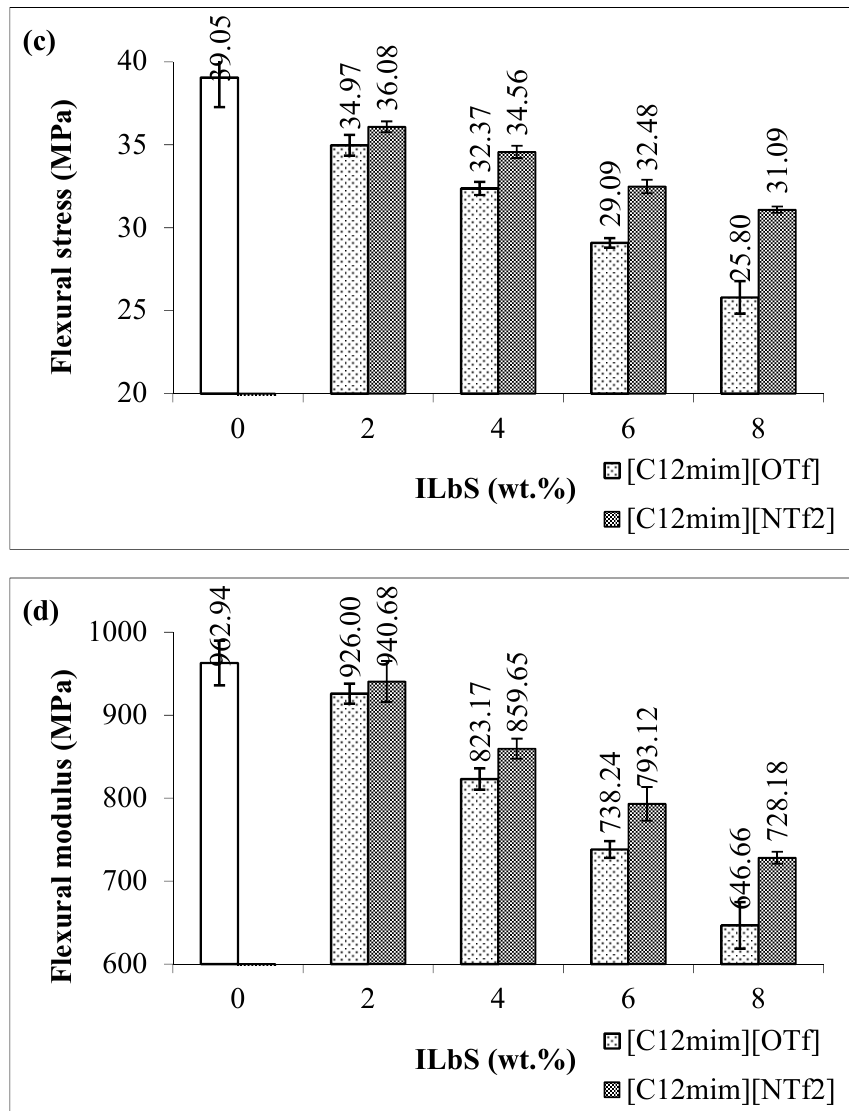
Figure 2. ( a ) Flexural extension, ( b ) flexural load, ( c ) flexural stress and ( d ) flexural modulus at Figure 2. (a) Flexural extension, (b) flexural load, (c) flexural stress and (d) flexural modulus at maximum load of the PBS / RS blends without and with di ff erent contents and types of ILbS. maximum load of the PBS/RS blends without and with different contents and types of ILbS. Table 3. ANOVA result of the flexural extension of the PBS/RS blends without and with containing Table 3. ANOVA result of the flexural extension of the PBS / RS blends without and with containing ILbS. ILbS. Source of Variation